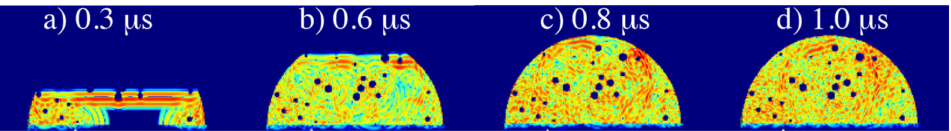
Figure 14. Simulated wave propagation in a 3 mm ice drop with 5% porosity. The transducer that sends and receives the ultrasonic signal is located on the flat surface at the bottom of the panels. The time for each snapshot after emission of the pulse is indicated. Darker red and yellow represent stronger waves (higher amplitudes), while blue colours correspond to low amplitudes. Even for this low value of porosity, the strong dissipating effects caused by pores do not allow the reflected wave front (reaching the top of the drop surface after 0.8 µ s) to travel back to the